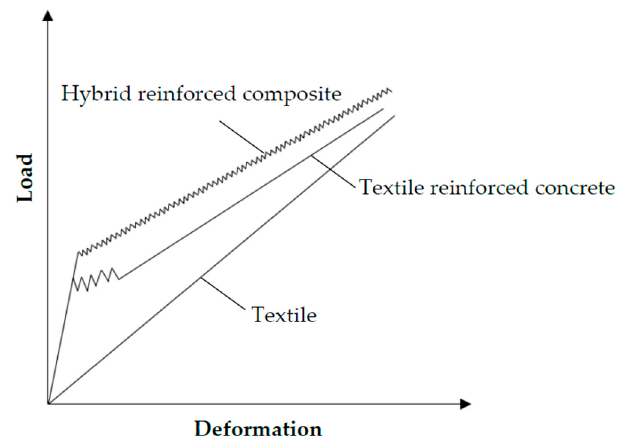
Figure 1. Schematic presentation of tensile load-deformation behavior of textile reinforcement, textile reinforced concrete, and hybrid reinforced composite.